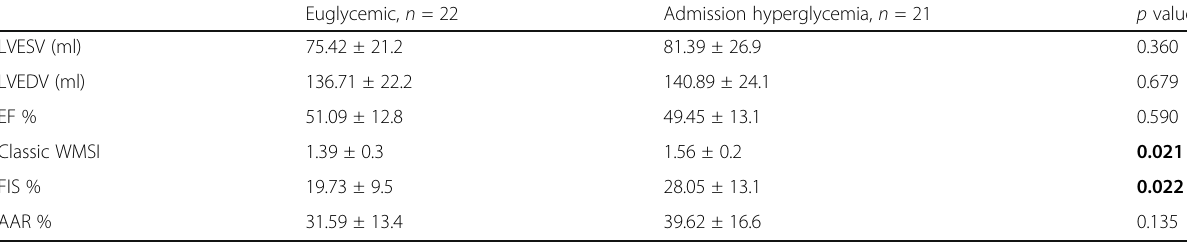
Table 3 Cardiovascular magnetic resonance imaging findings